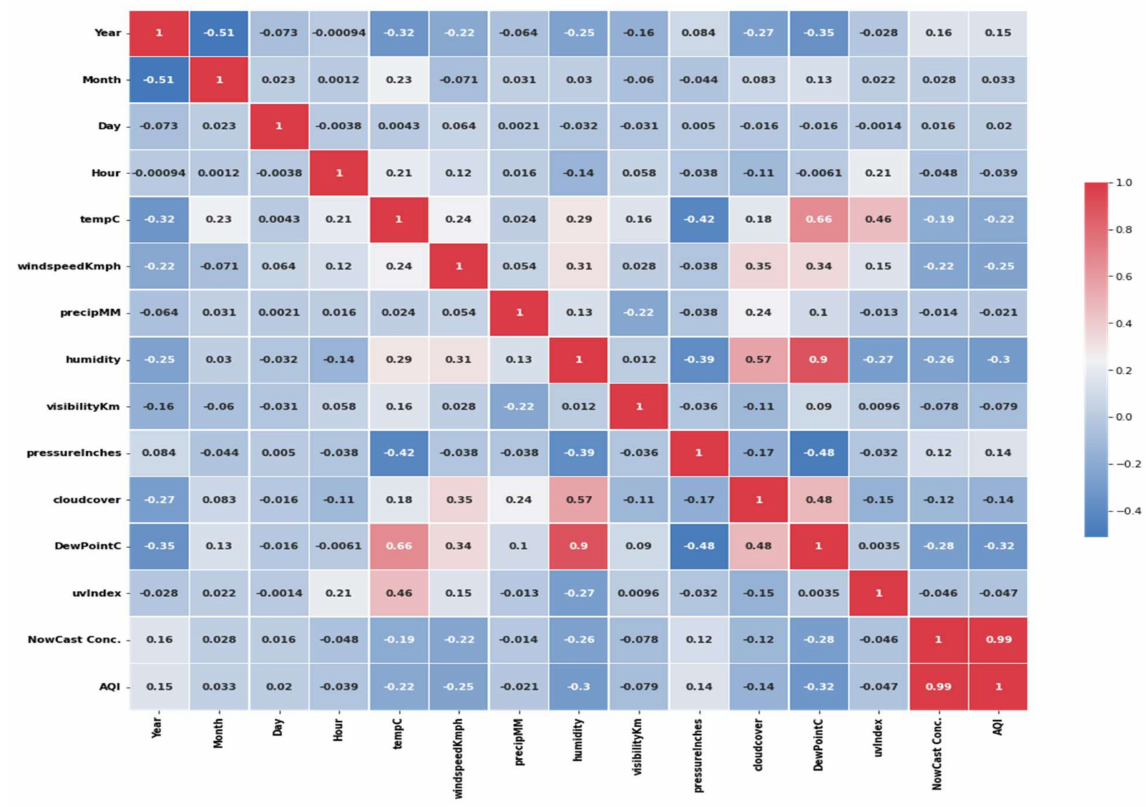
Figure 22. Depiction of the daily distribution of PM 2.5 concentration according to EPA standards for Karachi.